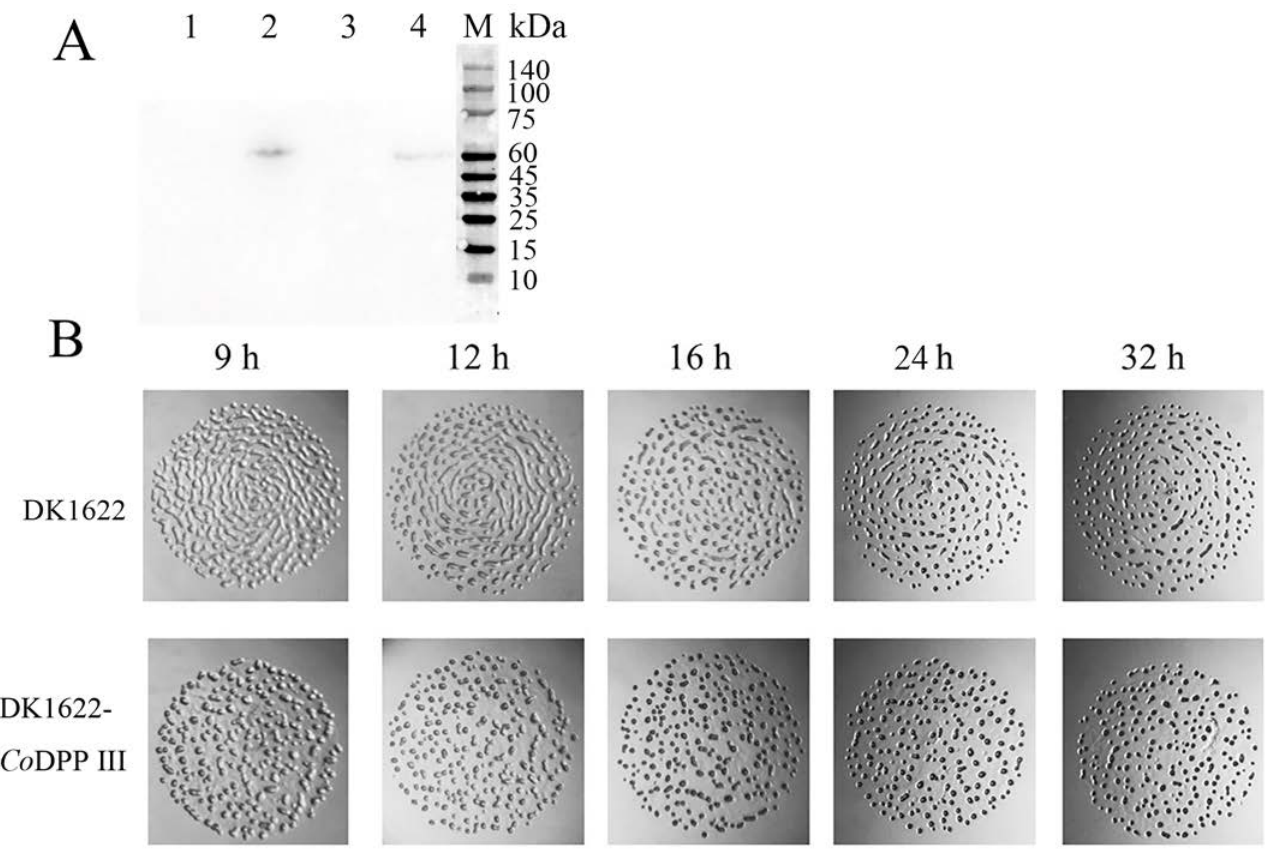
Figure 9. Analysis of Co DPP III expression and developmental timing in wild-type and mutant strains. ( A ) Western blot using anti-his antibody. Co DPP III was expressed in vegetative cells (lane 2) and developmental cells (lane 4) in DK1622- Co DPP III, but not in wild-type DK1622 (lane 1 and 3). ( B ) Developmental time course of fruiting body morphogenesis on TPM starvation agar.